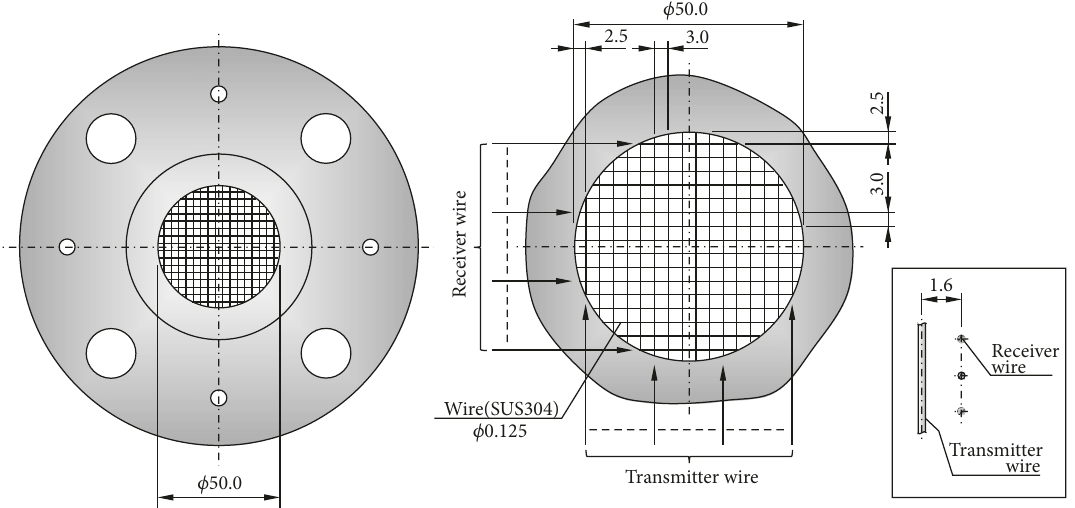
Figure 2: 16 × 16 grid sensor image to verify